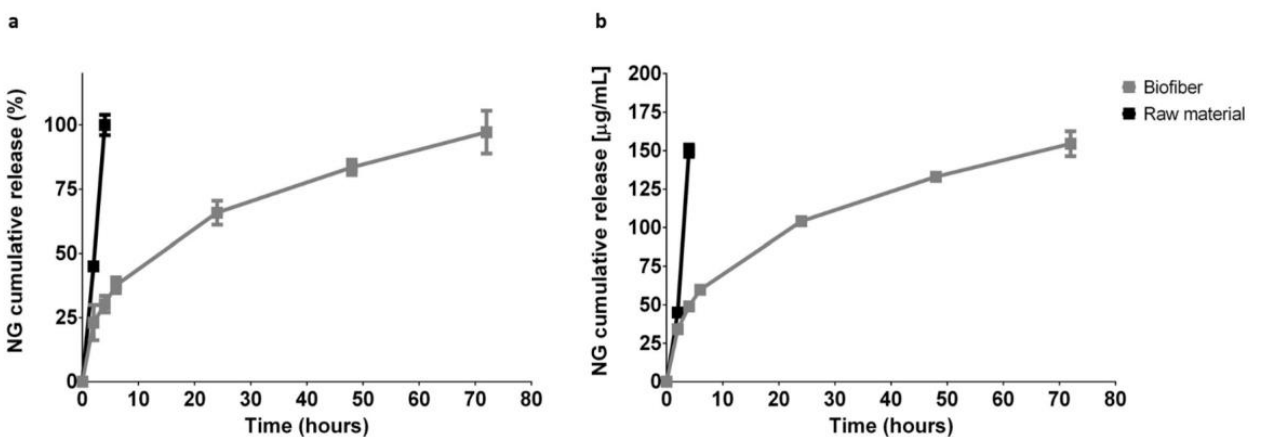
Figure 9. In vitro cumulative release expressed as ( a ) NG cumulative release (%) and ( b ) NG cumu- lative release [µg/mL] vs. time. Samples were incubated in PBS 1X, pH 7.4 at 34 °C, in static condi- tions. Dissolution of NG powder (Raw material) was used as control. In vitro release analyses were measured by UV – Vis spectrophotometer at 282 nm. Some standard deviations are not noticeable as <1.